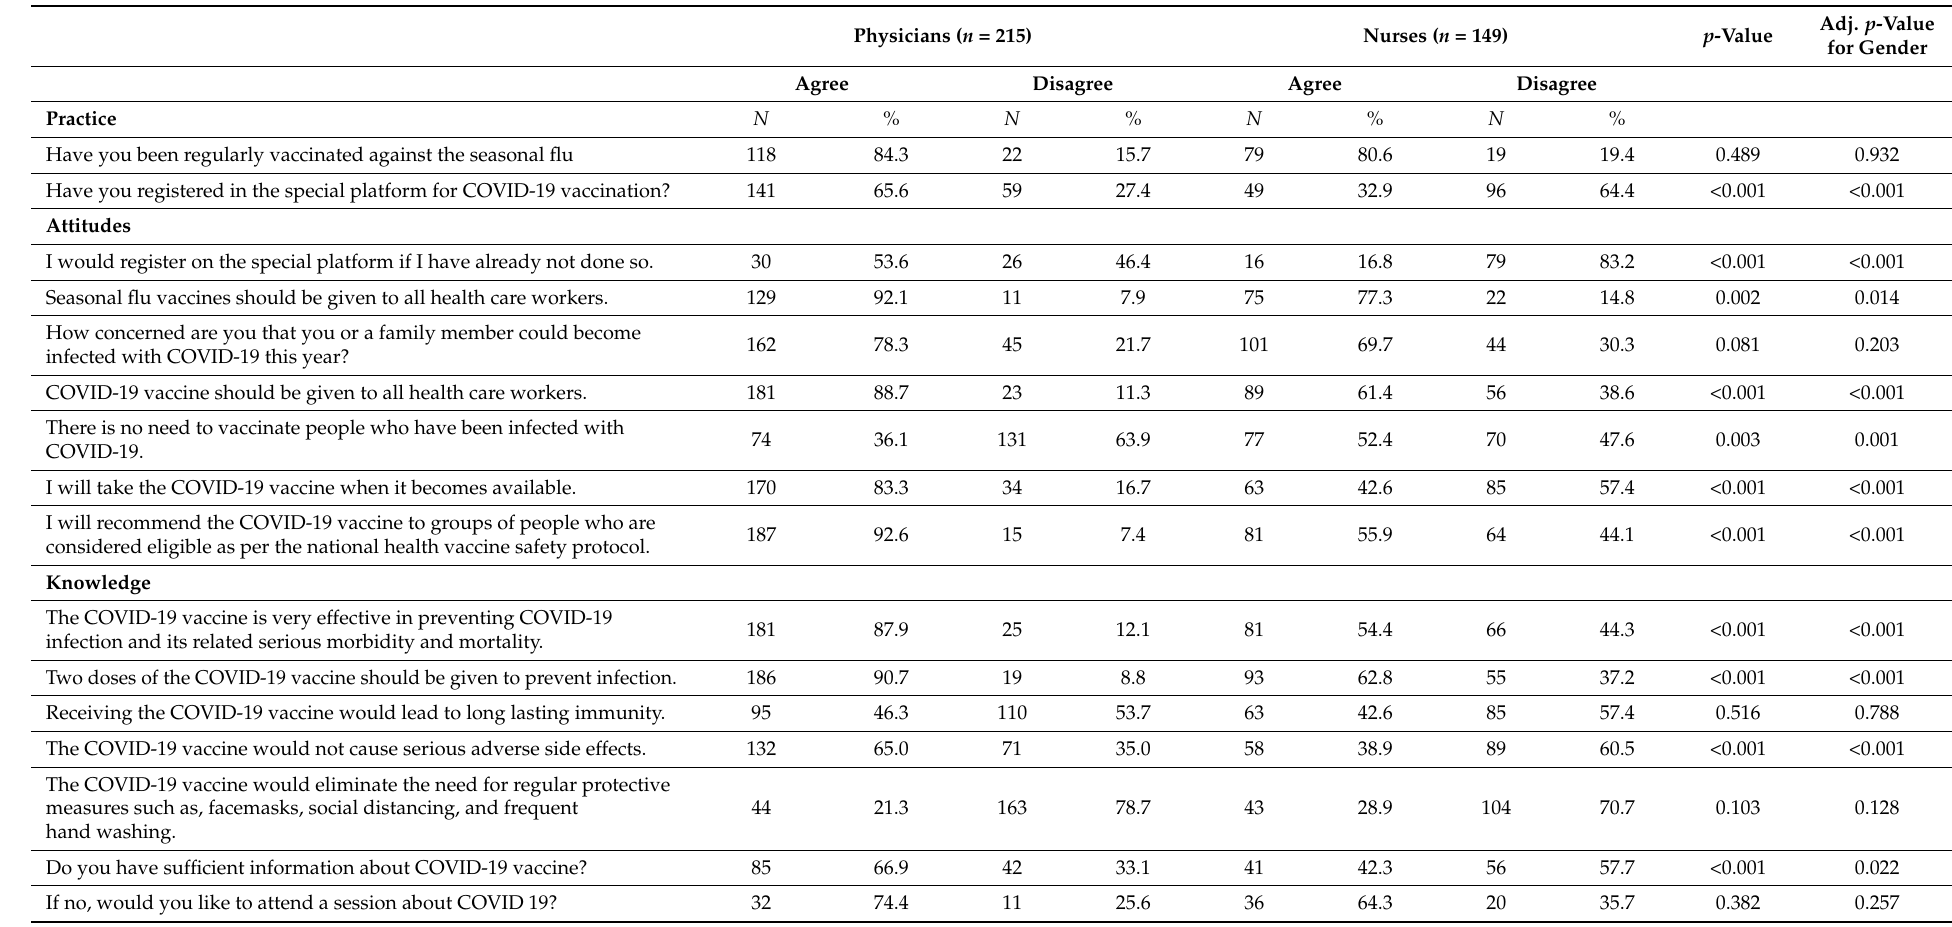
Table 2. Participants’ responses stratified by